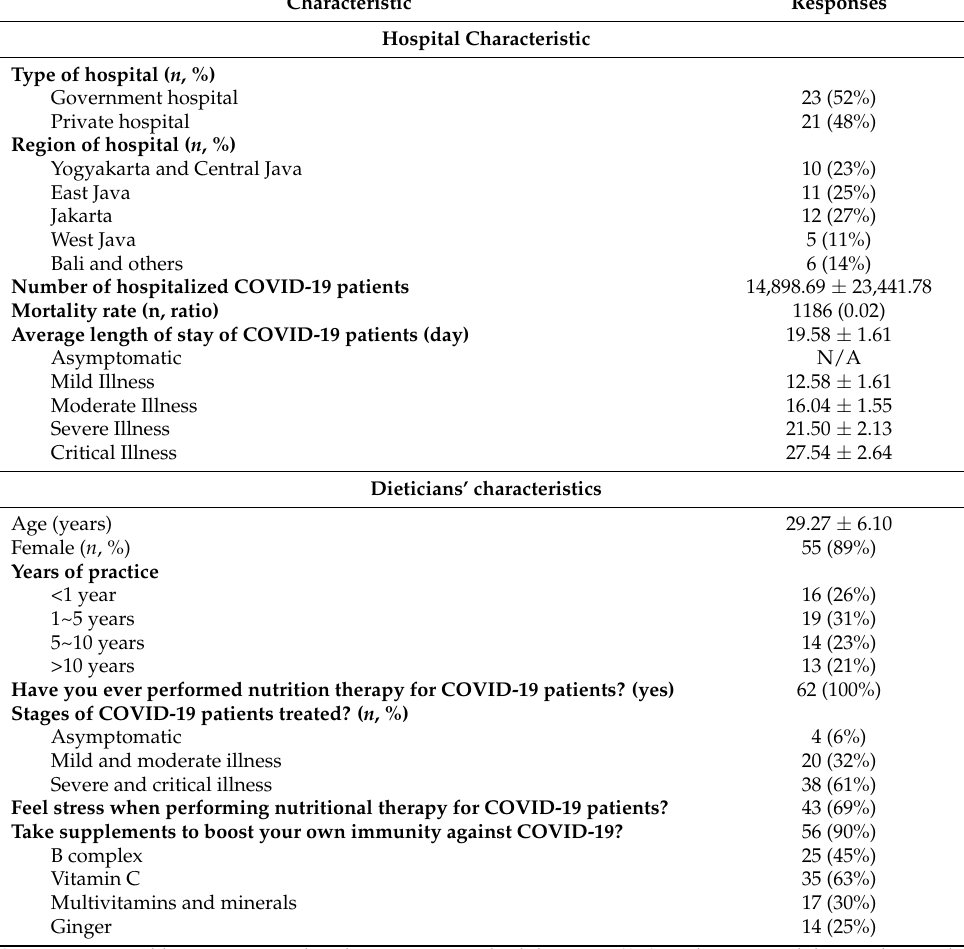
Table 1. Characteristics of the study participants ( N =